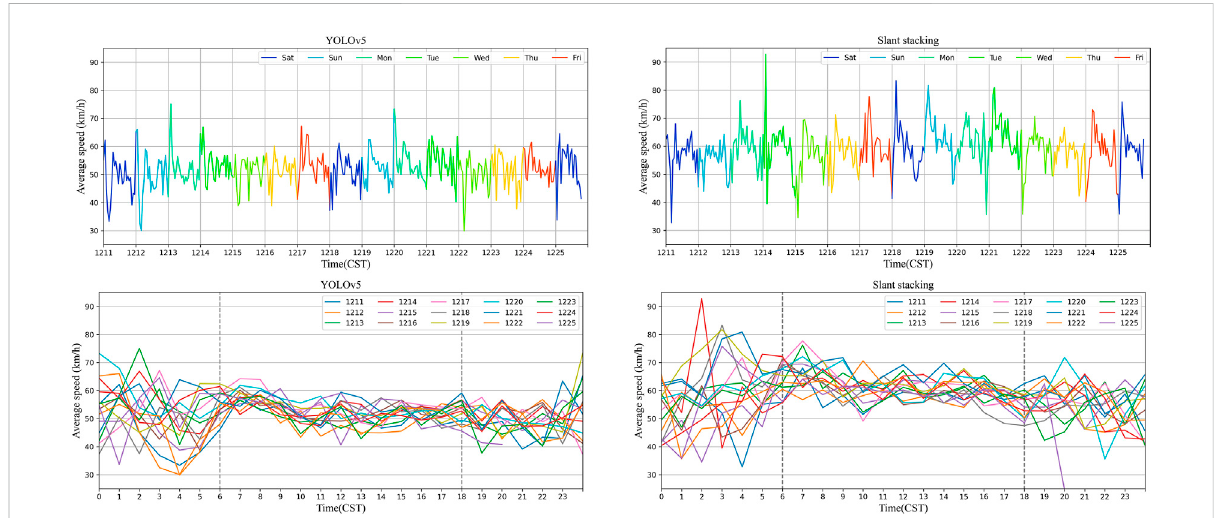
FIGURE 8 Figuresinthetoprowrepresentthedailyandweekly variations oftheaveragespeed,as estimatedbyYOLOv5 andtheslantstackingtechnique. The fi gures in the second row represent hourly variations of the same methods. The gray dot line in the second row of fi gures divides each day into three distinct time intervals with varying average speed trends.